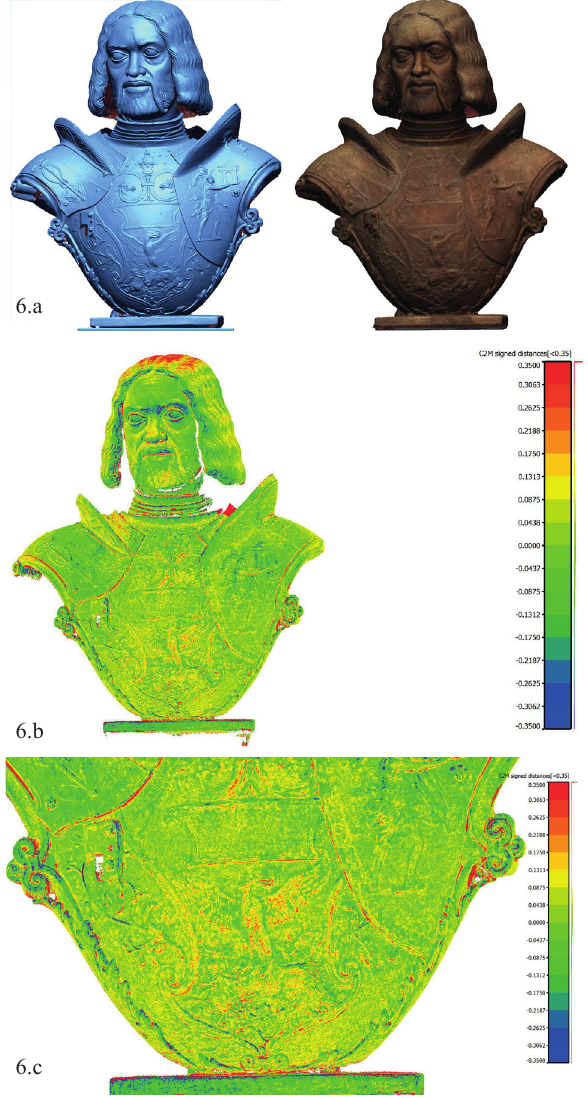
Figure 6: a) the two models compared: on the left the range camera model, on the right the photogrammetric one; b)comparison between two models: the maximum positive and negative difference is 0.35 mm where there are no